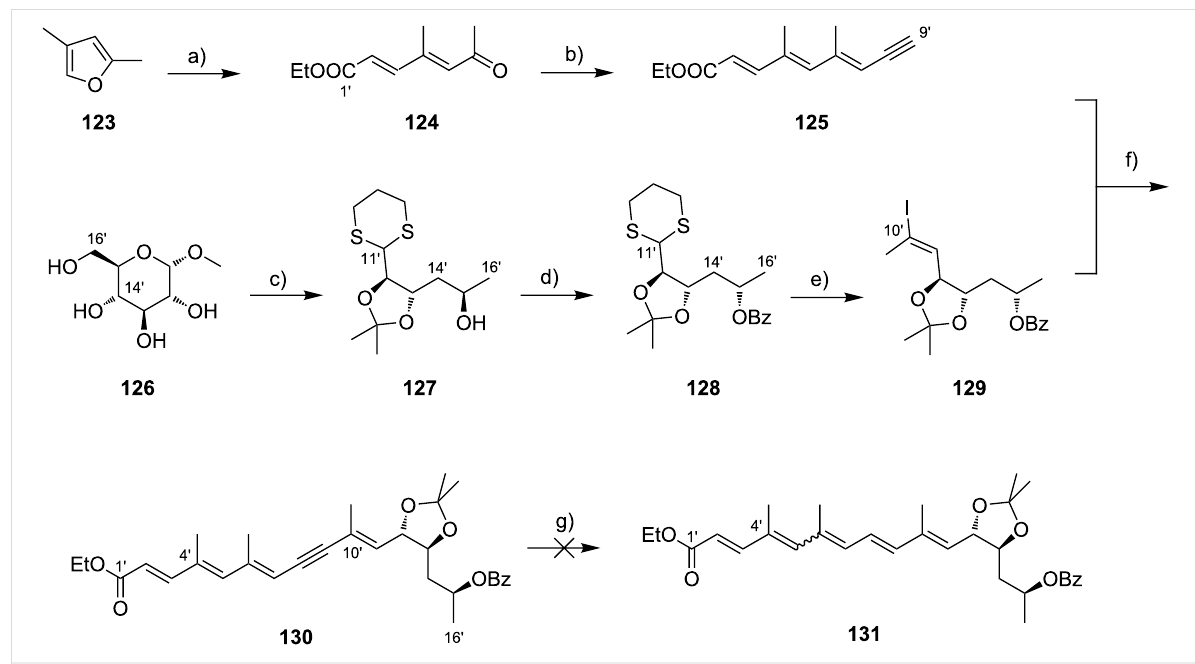
Scheme 16: Feringa and Minnaard's incomplete synthesis of mycolactone A/B pentaenoate side chain. Reagents and conditions: a) (i) Rh 2 (OAc) 4 (0.4 mol %), CH 2 Cl 2 , ethyl diazoacetate, rt; (ii) I 2 , CH 2 Cl 2 , rt; b) (i) TMS–C ≡ C–CH 2 –P(O)(OEt) 2 , n -BuLi, THF, 0 °C to rt, 61%; (ii) TBAF, THF, EtOAc, 0 °C, 80%; c) (i) SO 2 Cl 2 , pyridine, CHCl 3 , − 78 °C to 50 °C, 56%; (ii) Bu 3 SnH, AIBN, toluene, reflux, 89%; (iii) 1,3-propanedithiol, conc. HCl, 87%; (iv) acetone, CuSO 4 , H 2 SO 4 , 95%; d) PPh 3 , BzOH, DEAD, THF, 82%; e) (i) MeI, 2,4,6-collidine, acetone, H 2 O, reflux, 89%; (ii) PPh 3 , CBr 4 , CH 2 Cl 2 , 0 °C to rt, 72%; (iii) LDA, THF, − 78 °C, 88%; (iv) LDA, HMPA, MeI, THF, − 78 °C to − 10 °C, 88%; (v) Pd(PPh 3 ) 2 Cl 2 , Bu 3 SnH, pentane, 63%; (vi) CH 2 Cl 2 , I 2 , − 78 °C to rt, 99%; f) Pd(PPh 3 ) 4 , CuI, iPrNH 2 , 94%; g) H 2 , Lindlar catalyst, hexanes, EtOAc, quinoline; or Zn, Cu(OAc) 2 ·H 2 O, AgNO 3 , H 2 O, MeOH; or H 2 , THF, Elsevier catalyst; or Ni(OAc) 2 ·4H 2 O, EtOH, H 2 , hydrazine, NaBH 4